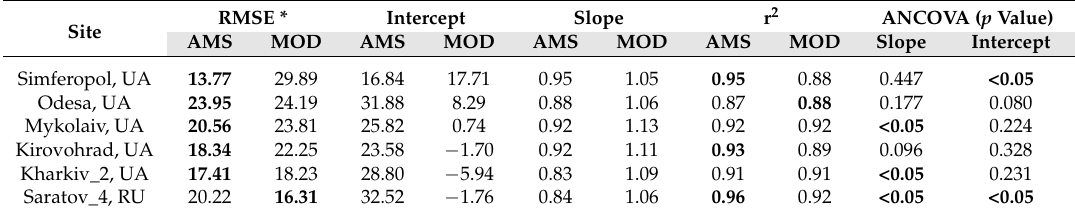
Table 5. Root mean square error (RMSE), linear regression model (intercept, slope and r 2 ), and analysis of covariance (ANCOVA) between station and satellite GDDs from AMSR-E and MODIS sensors. AMS = AMSR-E; MOD = MODIS.